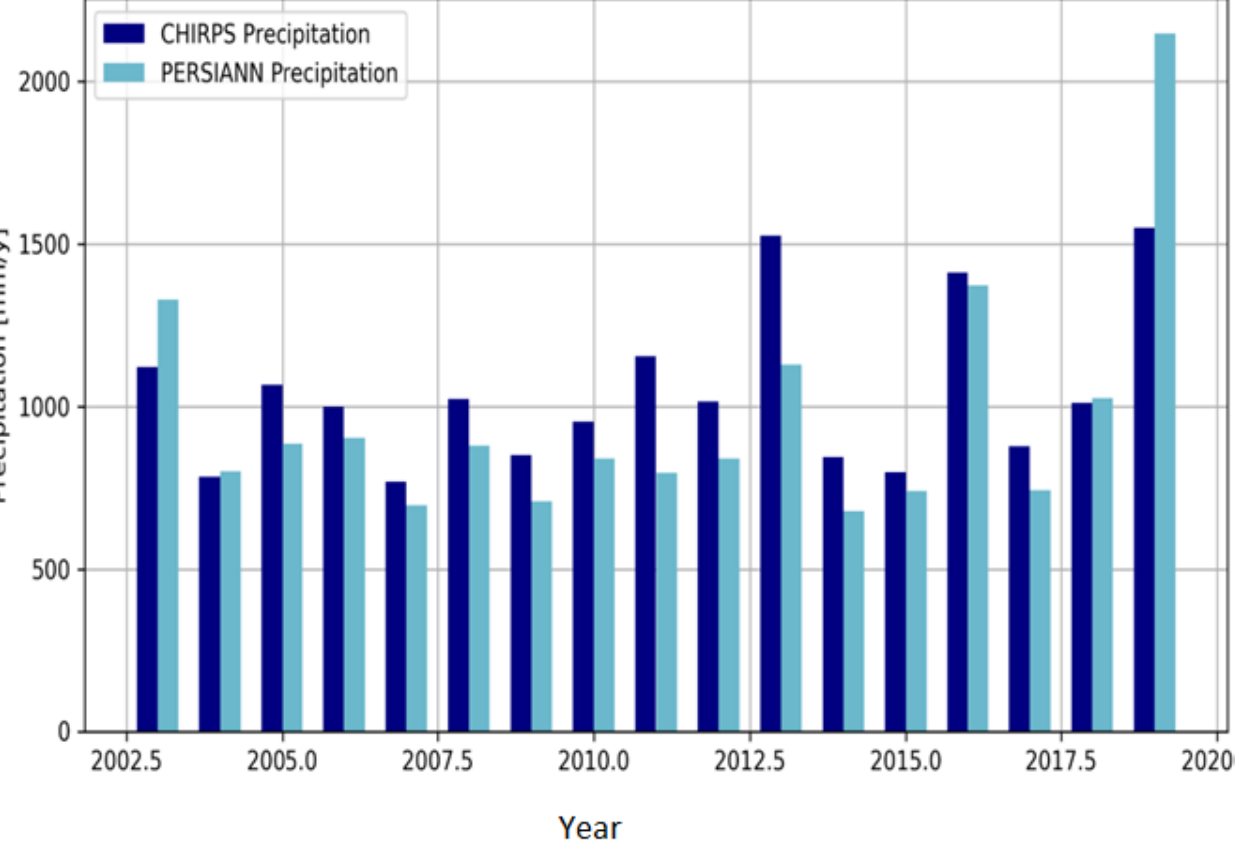
Figure 4. Figure portraying average annual precipitation derived from PERSIANN and CHIRPS datasets for the whole study period.